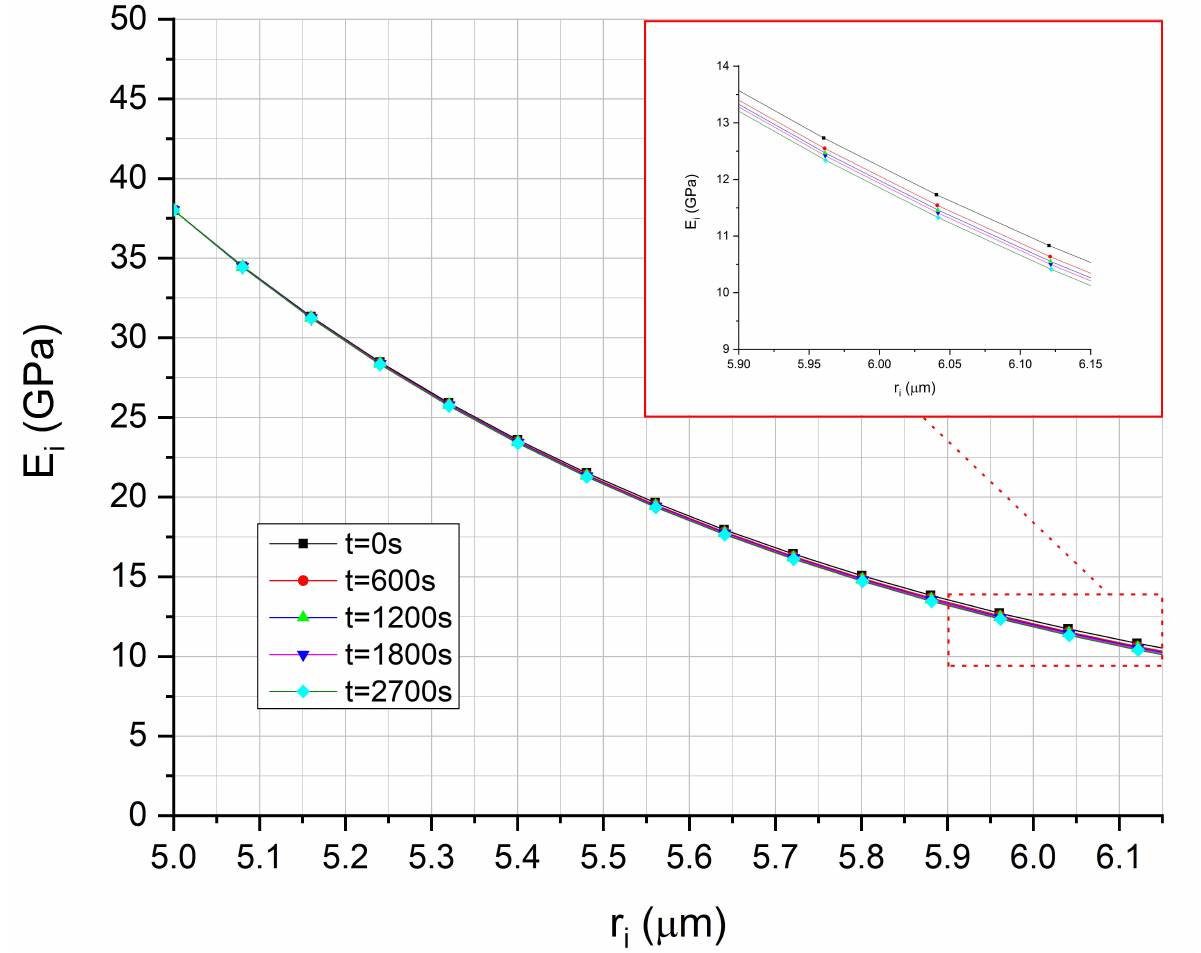
Figure 13. Prediction of hybrid viscoelastic interphase modulus as a function of the distance from the E-glass fiber for different time